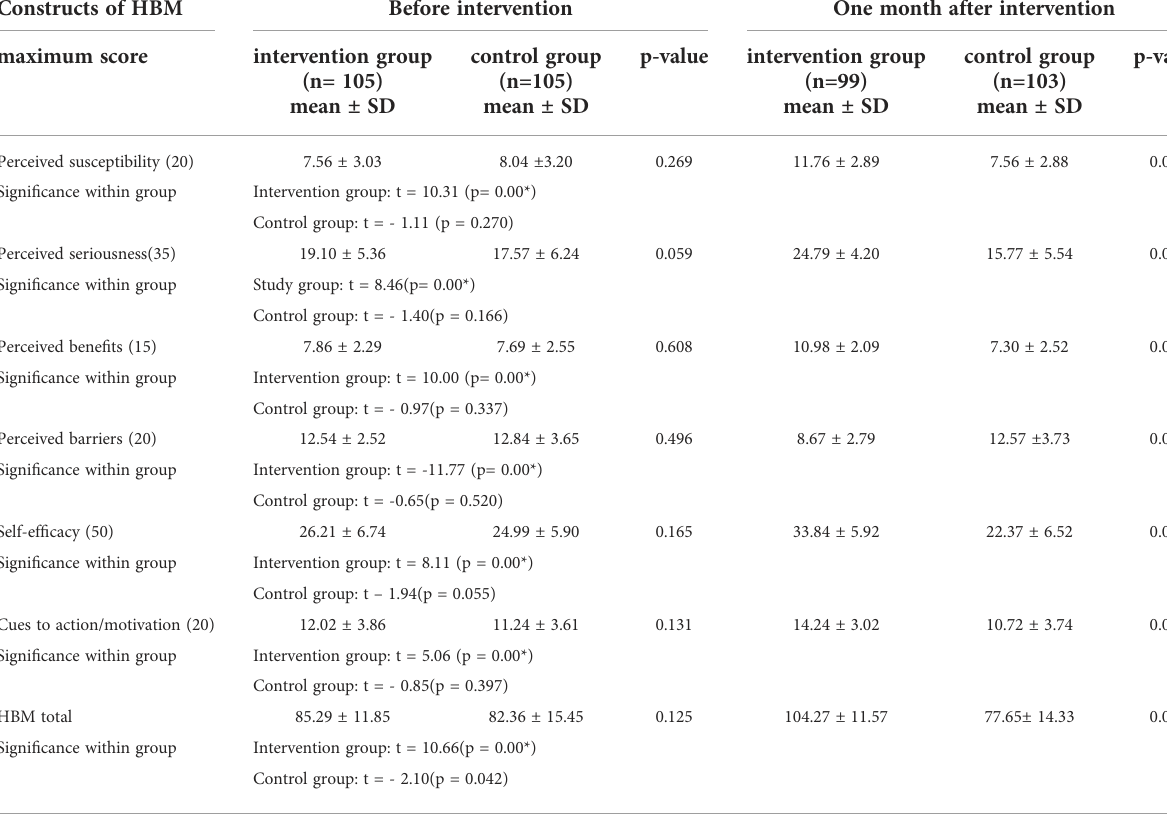
TABLE 3 Mean differences between the study and control groups regarding HBM constructs among female students of Debre Markos University, Amhara, Ethiopia before and 1 month after educational intervention about BC based on HBM (n = 210) 2021. Constructs of